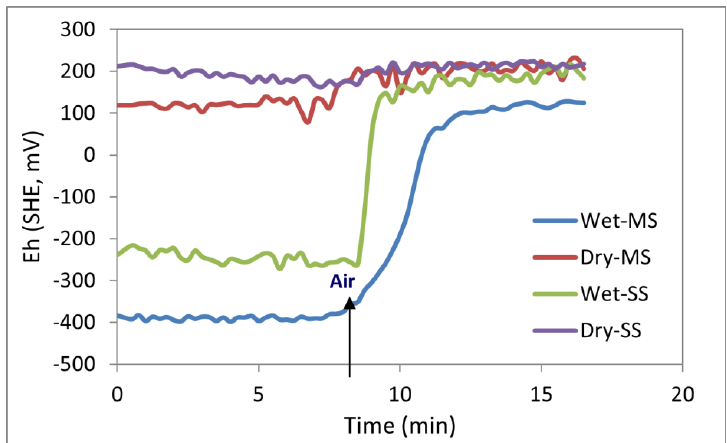
Figure 1. Redox potential of the pulp during at different milling conditions.